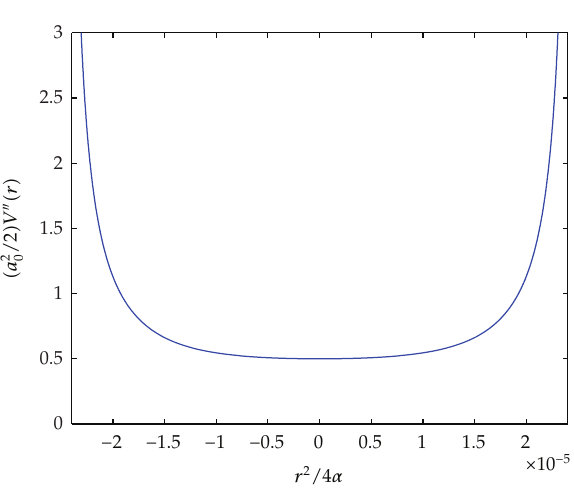
Figure 3: The Schwarzschild wormhole with a 0 /M (cid:5) 5 and α (cid:5) 10 − 10 . The region of stability is much reduced, implying that the wormhole is only stable to very small radial